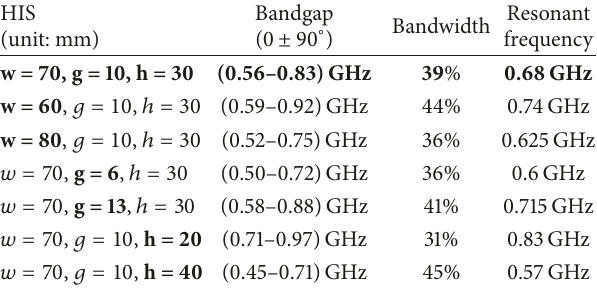
Table 1: Parameter study of HIS unit